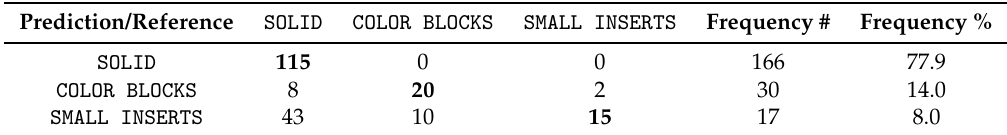
Table 10. Results on not-printed color combination on an unseen validation dataset, performed by the Adidas team. The numbers of correct predictions per class (on the main diagonal of the matrix) are highlighted in boldface